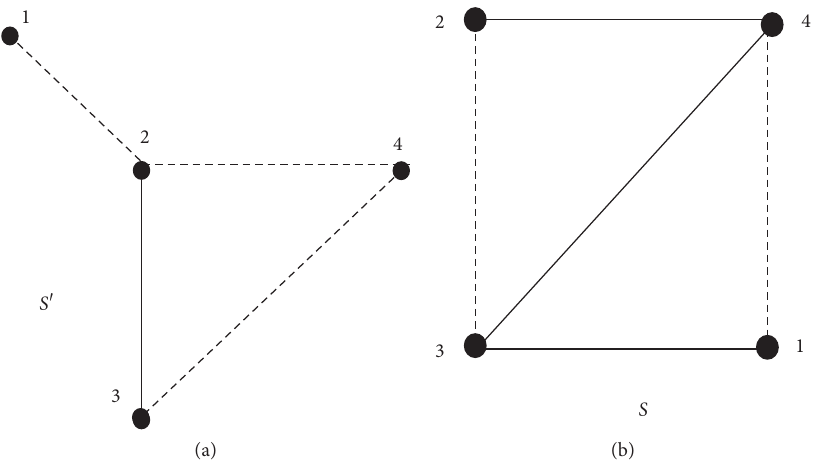
Figure 2: (a) Given signed network. (b) Its 2-path signed network.